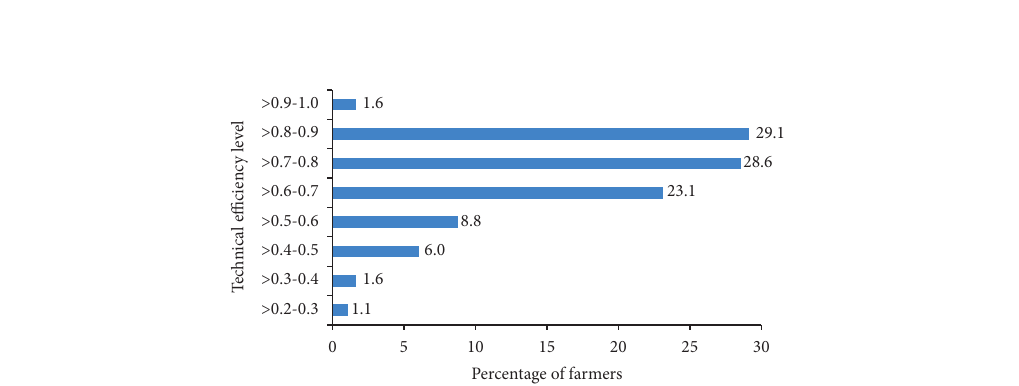
Figure 1: Farmers operating at different technical efficiency